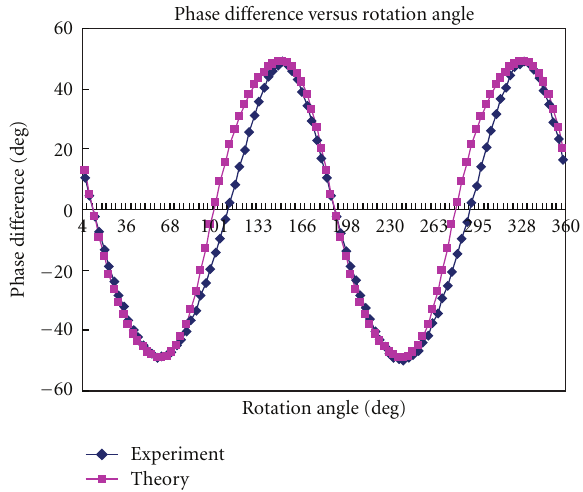
Figure 9: The experimental and theoretical